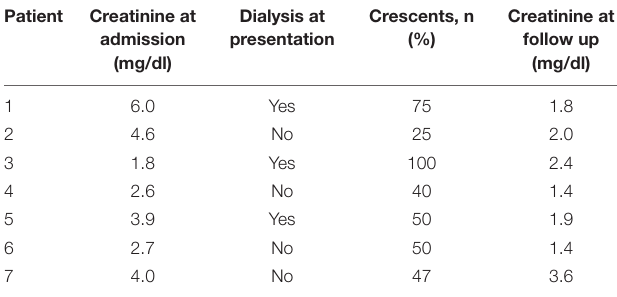
TABLE 3 | Patients who undergo plasma exchange and not developed